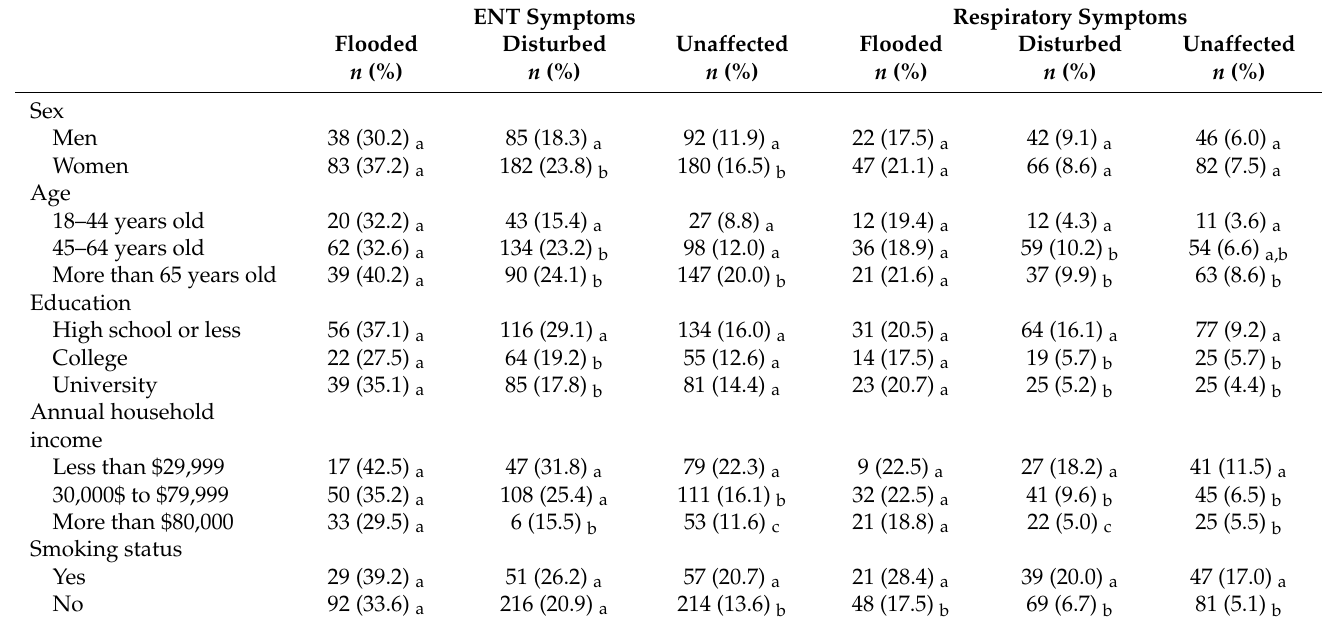
Table 4. Respiratory health according to personal characteristics and flood